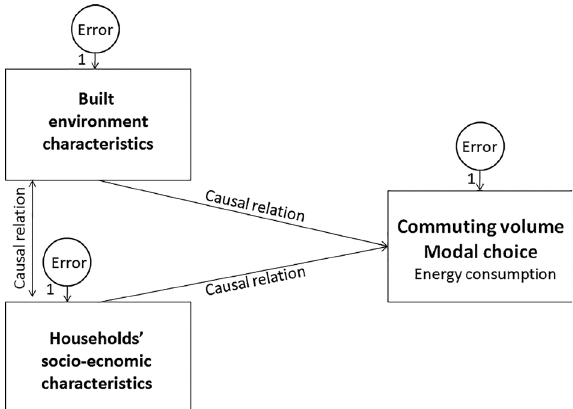
Fig. 2. Conceptual model explaining the need for